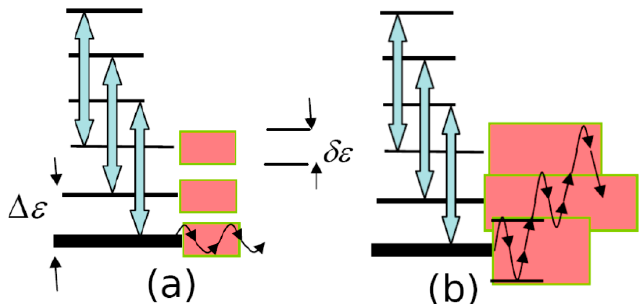
Figure 6. ( a ) Occurrence of dynamic nonlinear resonances without their widths δε overlapping. ( b ) Complete overlapping of widths δε , corresponding to the formation of the global dynamic chaos. The initial states correspond to the lowest levels n 0 (bold lines).